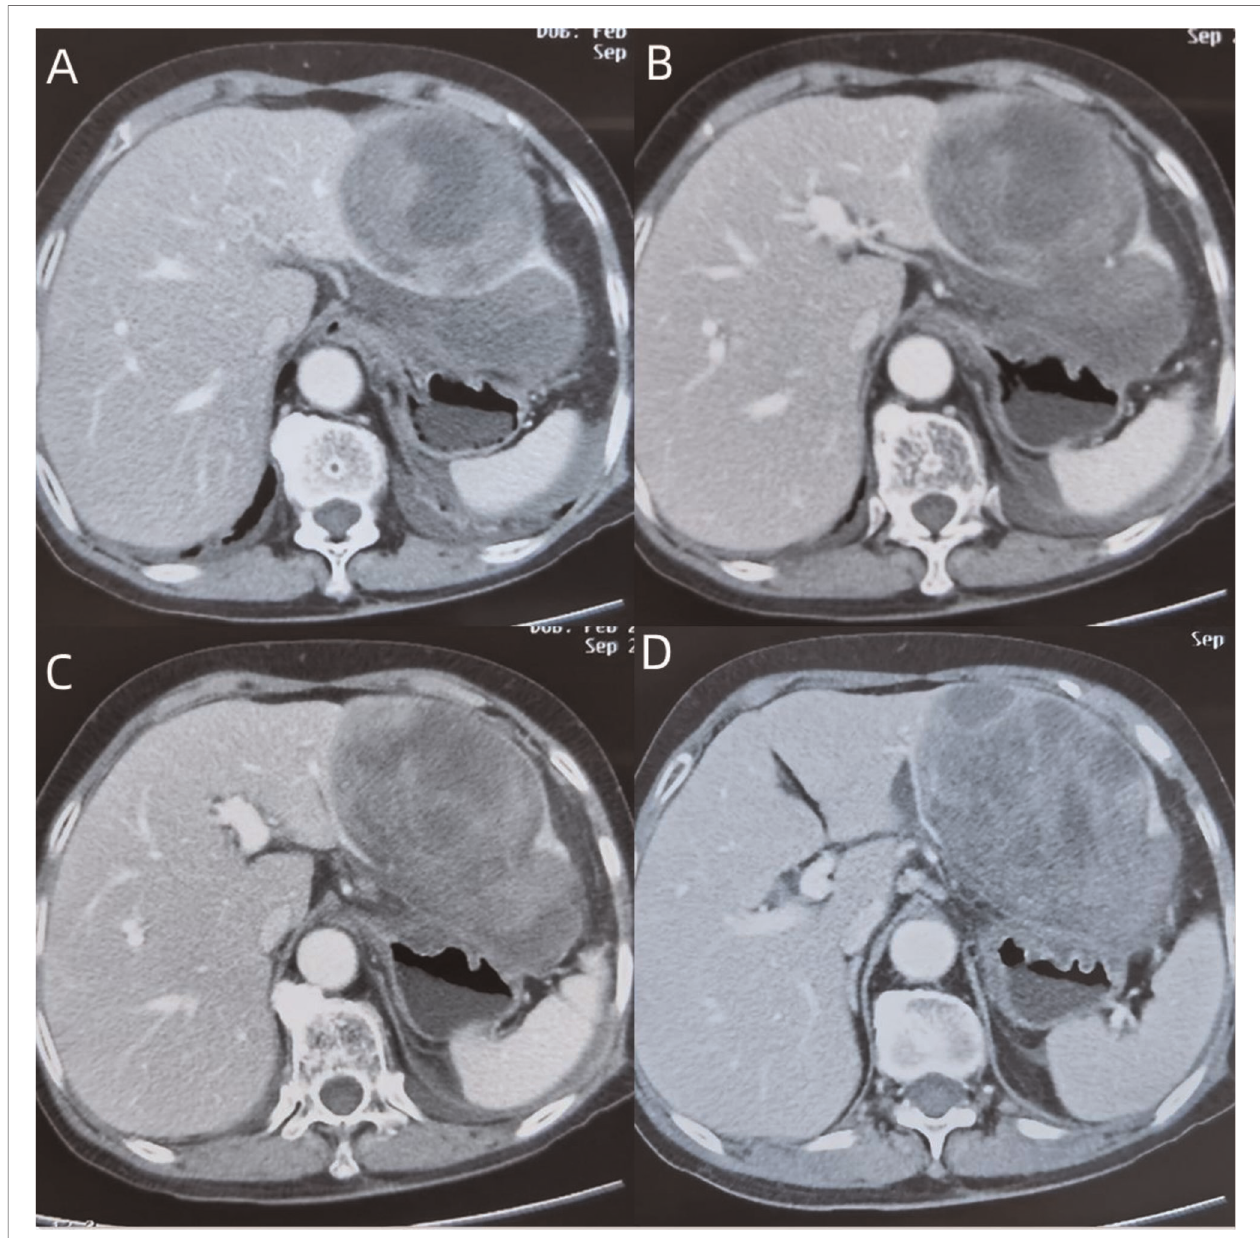
FIGURE 1 | ( A ) The lesion is located in the left lateral lobe of the liver, mainly in III segment, part of II segment, with a clear realm, a heterogeneous focal mass of expansive growth, irregular patchy low-density areas of internal tissue, uneven strengthening of peripheral tissue, but the density is still lower than that of normal liver tissue. ( B , C ) The continuity of the lower edge of the tumor is interrupted, and there is a fl uid accumulation in the hepatogastric space, which compresses the anterior wall of the stomach. ( D ) No enlarged lymph nodes are seen in the hepatic hilar, irregular cystic low-density areas appear at the inner edge of the tumor, and postoperative dissection con fi rms that the bile ducts are locally